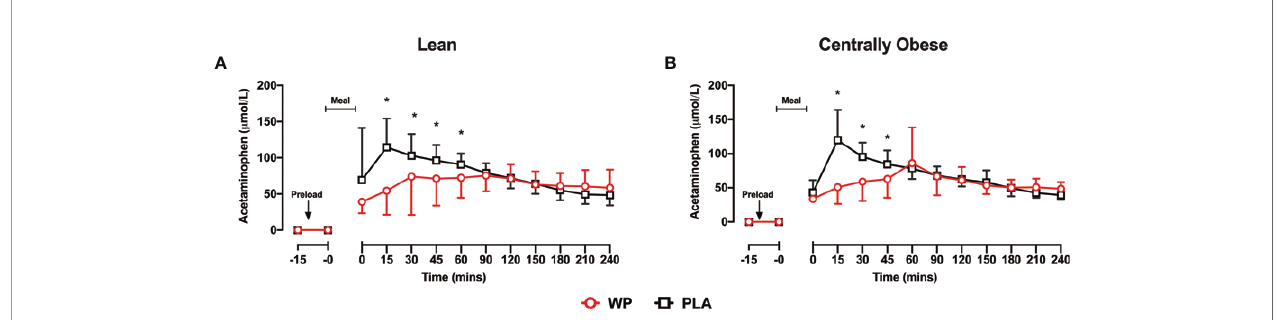
FIGURE 3 | Mean ± SD time-course changes in serum acetaminophen concentrations following the WP (red) and PLA preload (black) in lean (A) and centrally obese (B) males. Data were analysed by a mixed-model ANOVA with repeated measures (time and treatment). *Denotes a signi fi cant within-group treatment effect